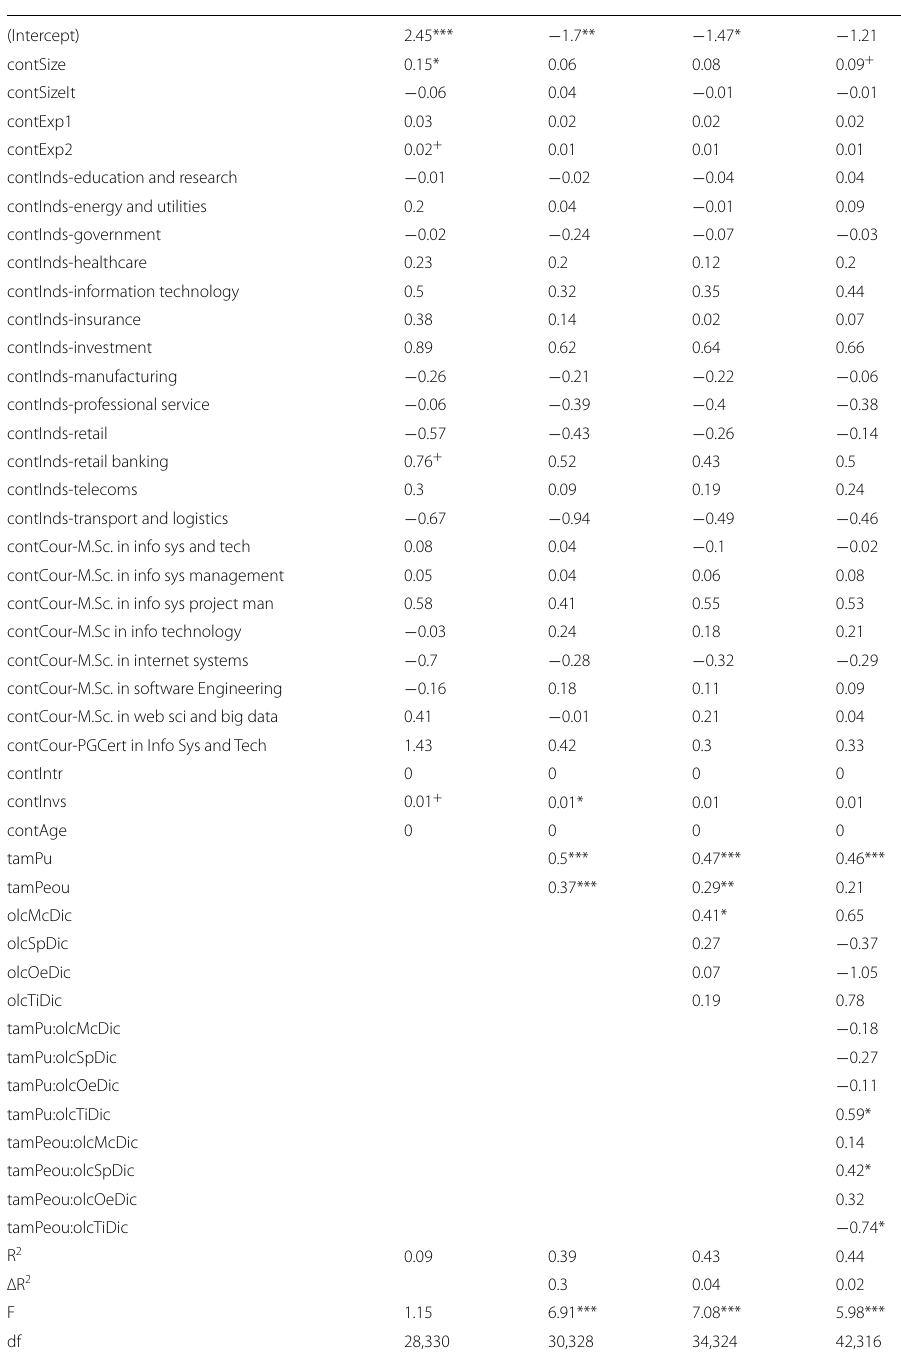
Table 7 Regression